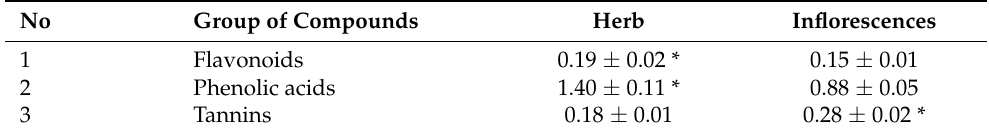
Table 3. The total content of phenolics (g × 100 g − 1